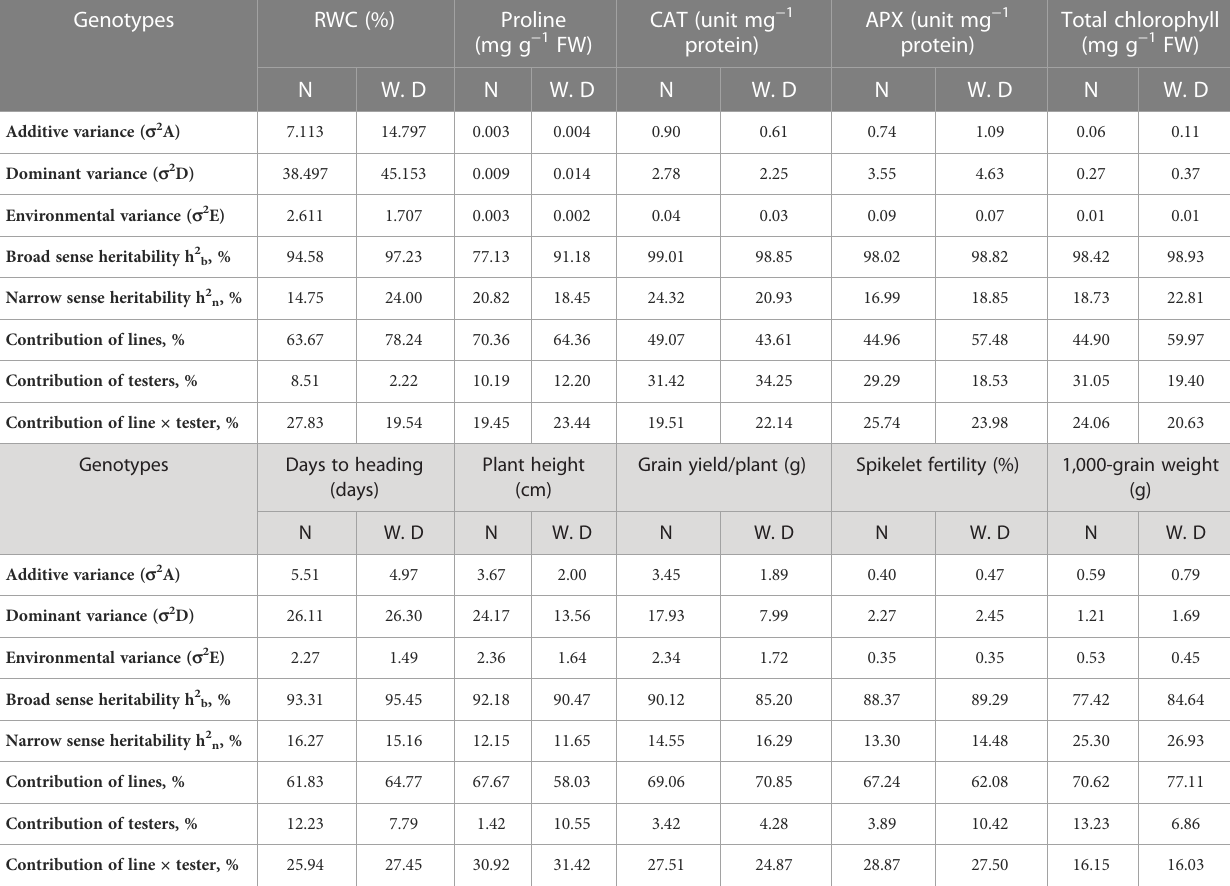
TABLE 7 Estimates of genetic parameters for physiological, biochemical, and yield-related (and its components) traits under normal watering and water de fi cit conditions.